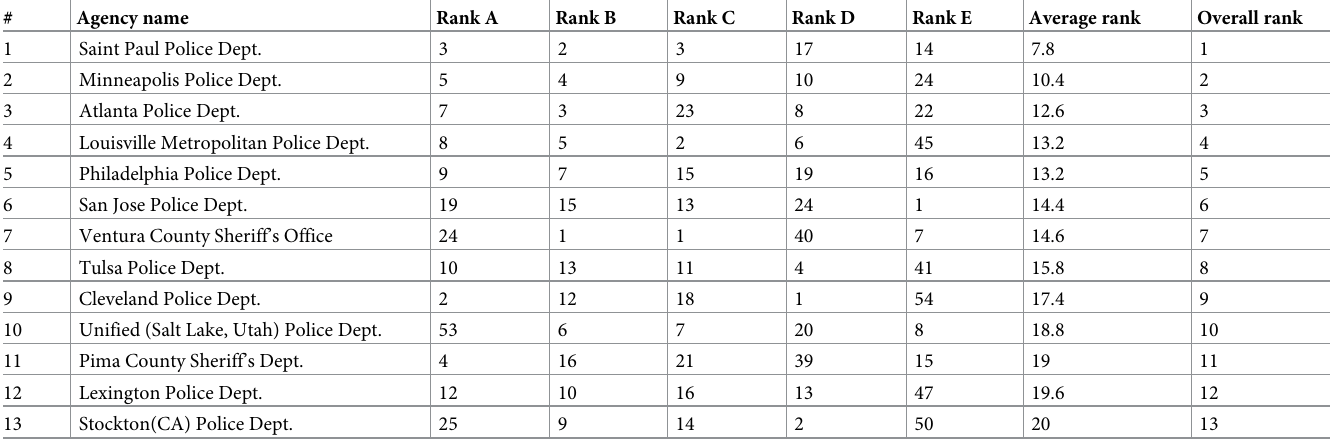
Table 14. Agencies (in the lower-use group) ranked by the five dimensions